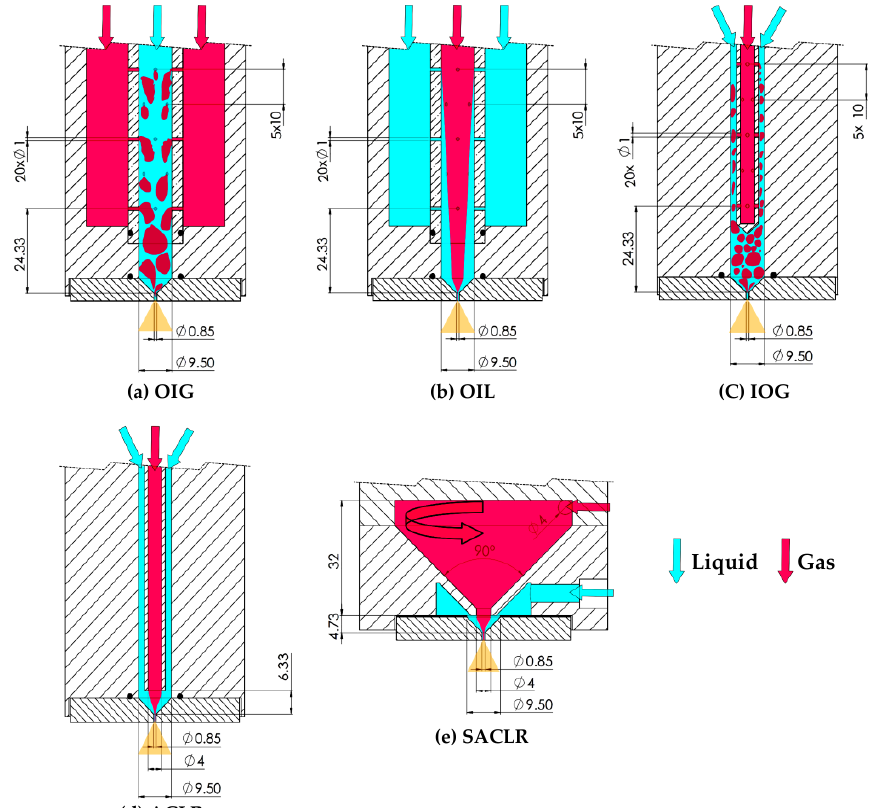
Figure 2. The geometry of the tested internal-mixing twin-fluid (IMTF) nozzles with their main dimensions in mm: ( a ) outside-in-gas (OIG); ( b ) outside-in-liquid (OIL); ( c ) inside-out-gas (IOG); ( d ) air-core-liquid-ring (ACLR); ( e ) swirling-air-core-liquid-ring (SACLR).